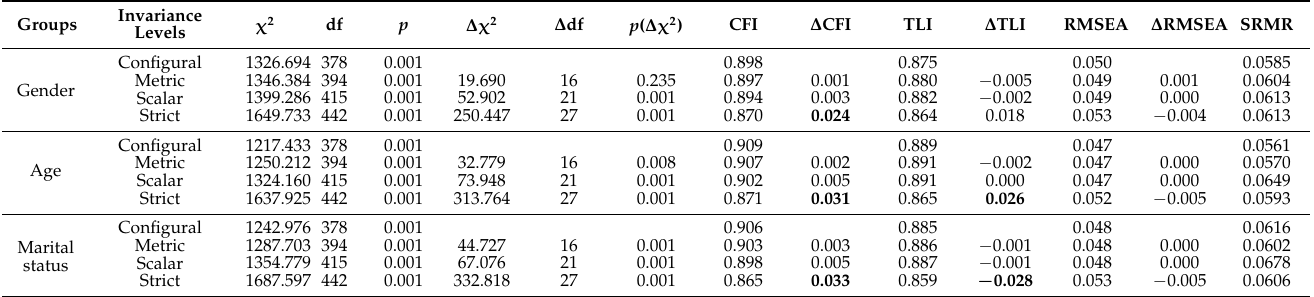
Table 5. Invariance of the six-factor structure (Model 7) of the Arabic version of the the Impact of Event Scale-Revised (IES-R) across groups of gender, age, and marital status among healthy